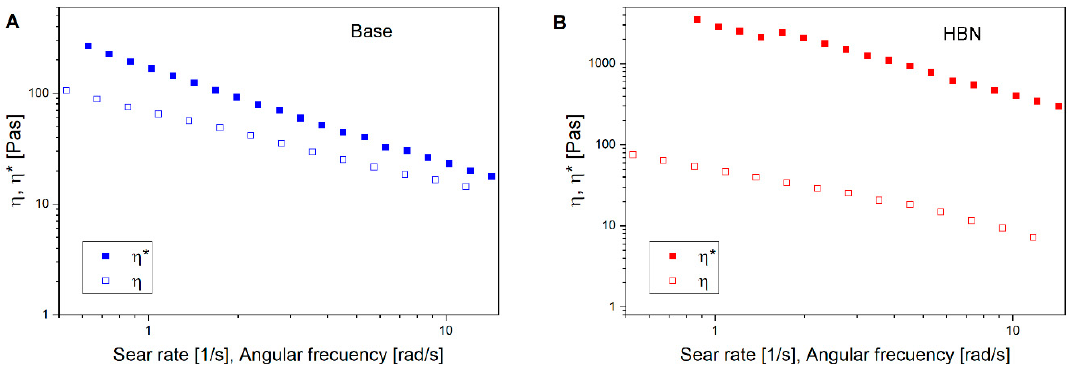
Figure 3. Comparison of shear viscosity with complex viscosity for ( A ) the control and ( B ) the formulation.